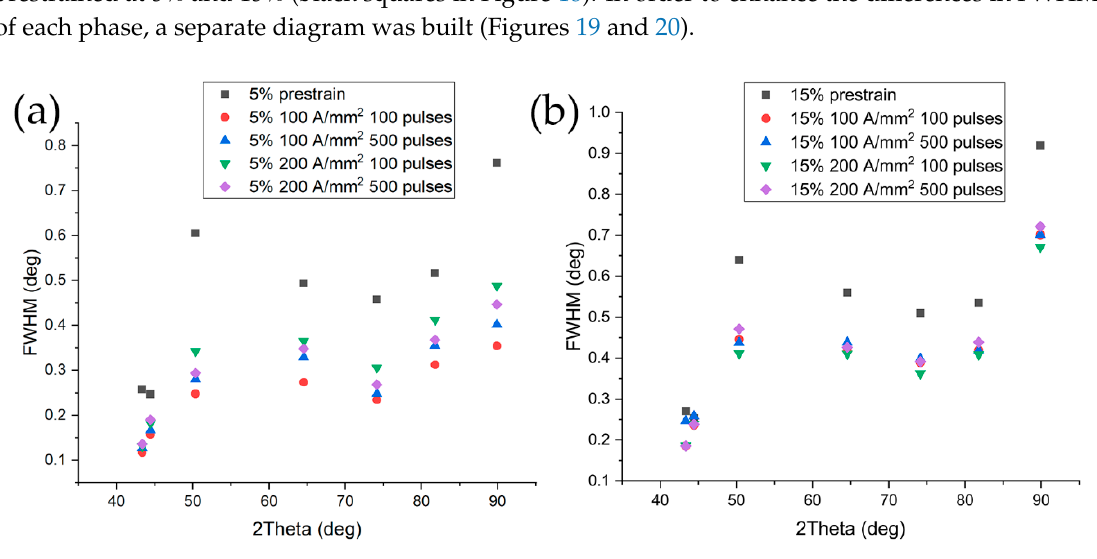
Figure 18. FWHM of the electropulsed specimens prestrained at ( a ) 5% and ( b ) 15%.